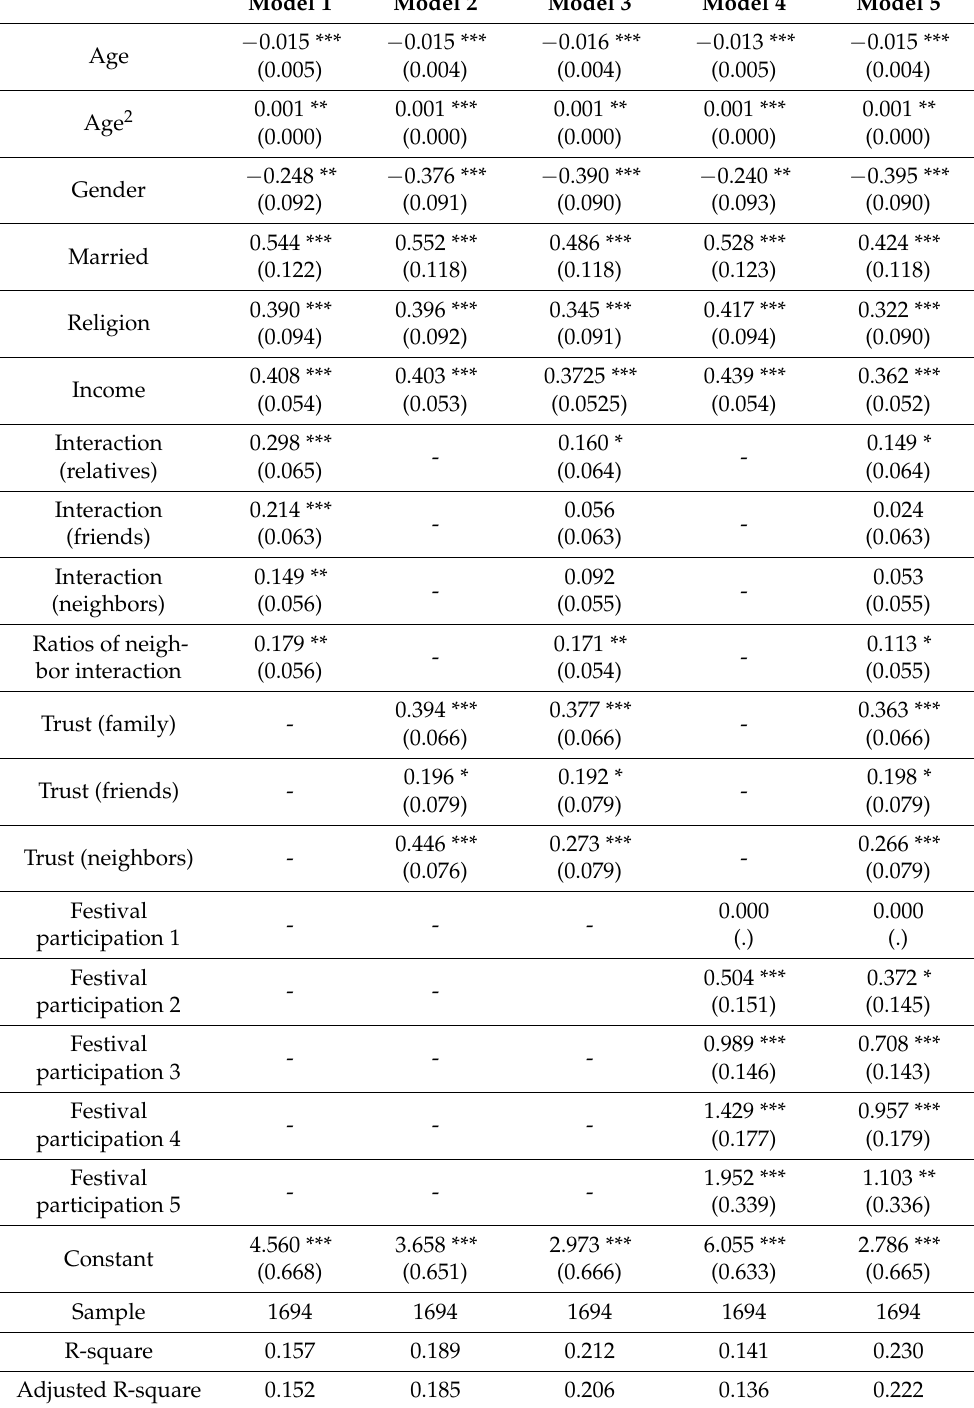
Table 2. Influences of social capital and festival participation on